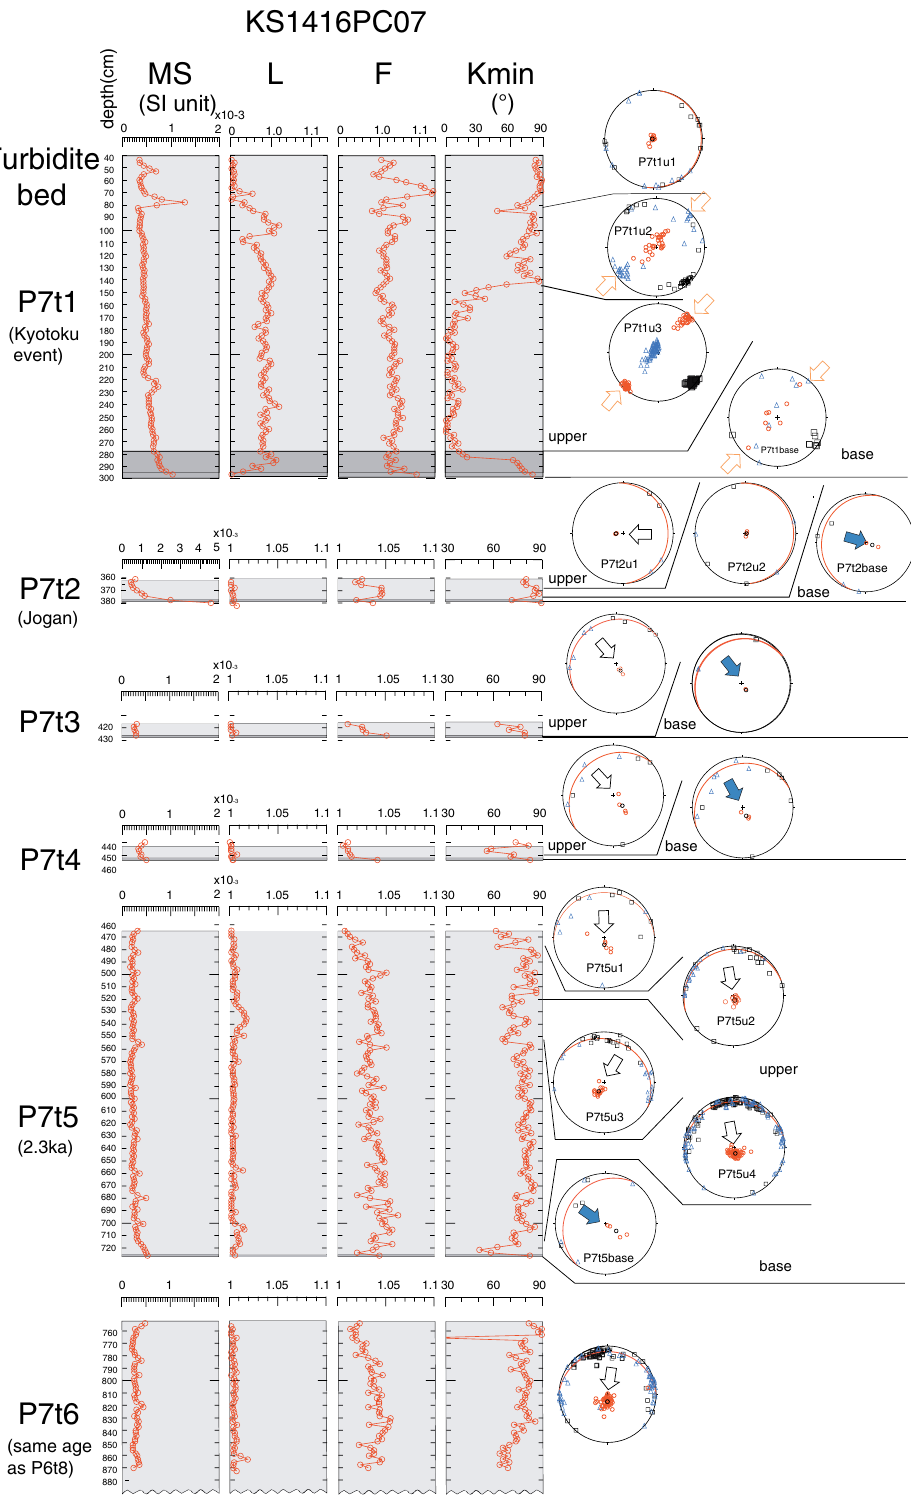
Fig. 10 AMS data of core KS1416PC07. Magnetic susceptibility (MS), “L” and “F” and Kmin inclinations of each turbidite beds and stereo plots of with inferred paleo flow. Blue filed arrows, basal sandy interval; white arrow, upper muddy interval; orange arrows, possible shearing, shorting, or rolling directions. Great circle perpendicular to the Kmin is drawn in red